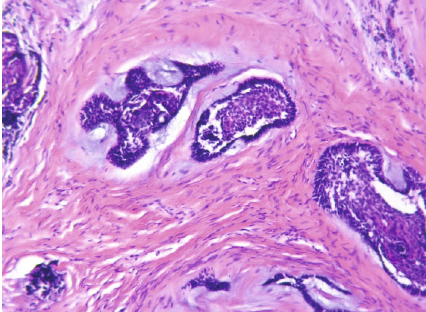
Figure 9: Optical microscopic picture showing in fi ltrating islands of ameloblast cells presenting a follicular architecture, extending into the connective tissue wall suggestive of the mural variant. Stained with hematoxylin and eosin, magni fi ed 100 times. Figure 6: Enucleation of the lesion.